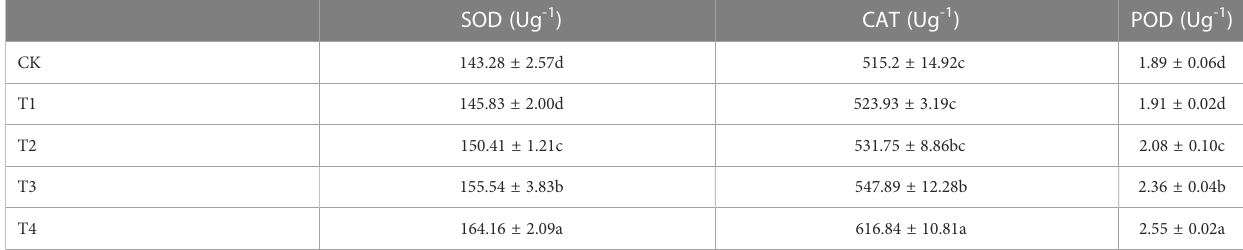
TABLE 3 Effects of different Si treatments on antioxidant enzymes activities of S. alfredii